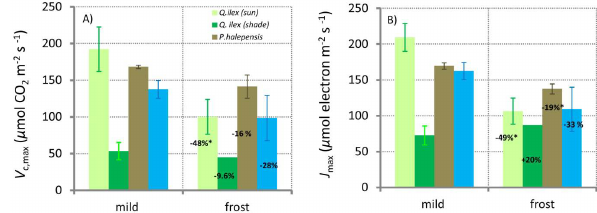
2 3 Figure 4. Bar plot of the effect of a sudden period of frost follow- ing a mild winter period on (a) net assimilation ( A net ) and (b) the effective quantum yield of net CO 2 assimilation ( 8 CO 2 ) in sunlit leaves of Q. ilex (light green bar), in shaded leaves of Q. ilex (dark green bar), P. halepensis (beige bar) and A. unedo (blue bar). The error bars represent the standard error, and the percentages indicate the change between periods where significance is indicated with an asterisk ( P ≤ 0 . 05) and marginal significance with an asterisk in parentheses (0 . 05 ≤ P ≤ 0 . 1).